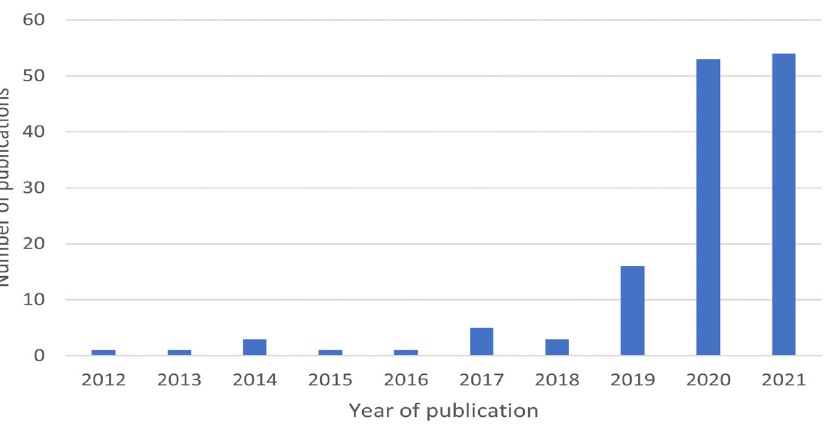
Figure 3. Documents published from 2012 to 2021 under the search criterion [TITLE ‐ ABS ‐ KEY (“biochar” AND “advanced” AND “oxidation” AND “process”)].